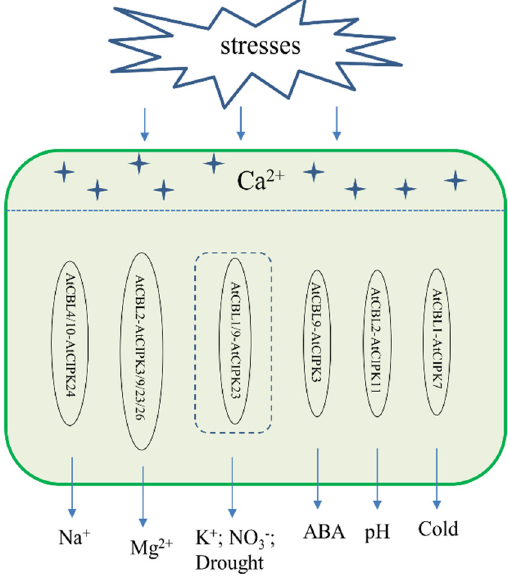
Figure 1. Plant CBL–CIPK signaling system. Plants respond to different stresses through the CBL– Figure 1. Plant CBL − CIPK signaling system. Plants respond to different stresses through the CIPK CBL − CIPK Complex.